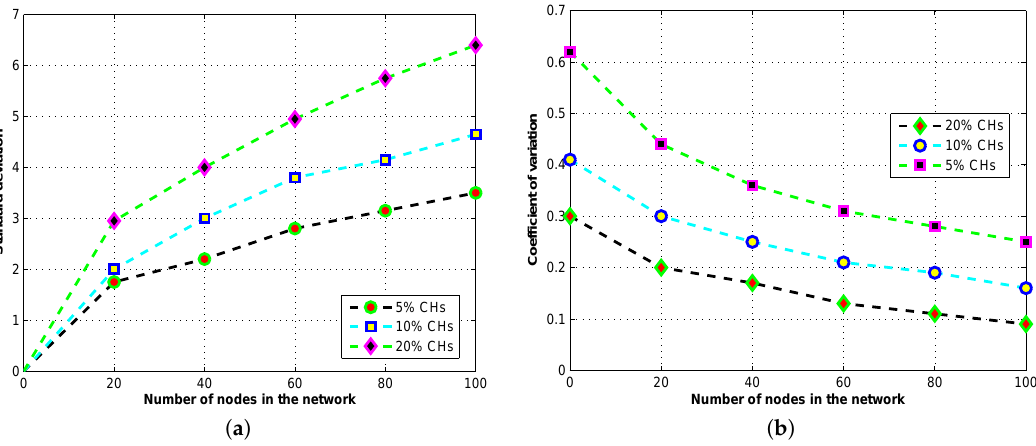
Figure 9. The number of clusters and CHs analysis through standard deviation, and the coefficient of variation. ( a ) The standard deviation of CHs in the network; ( b ) The coefficient of variation of CHs in the